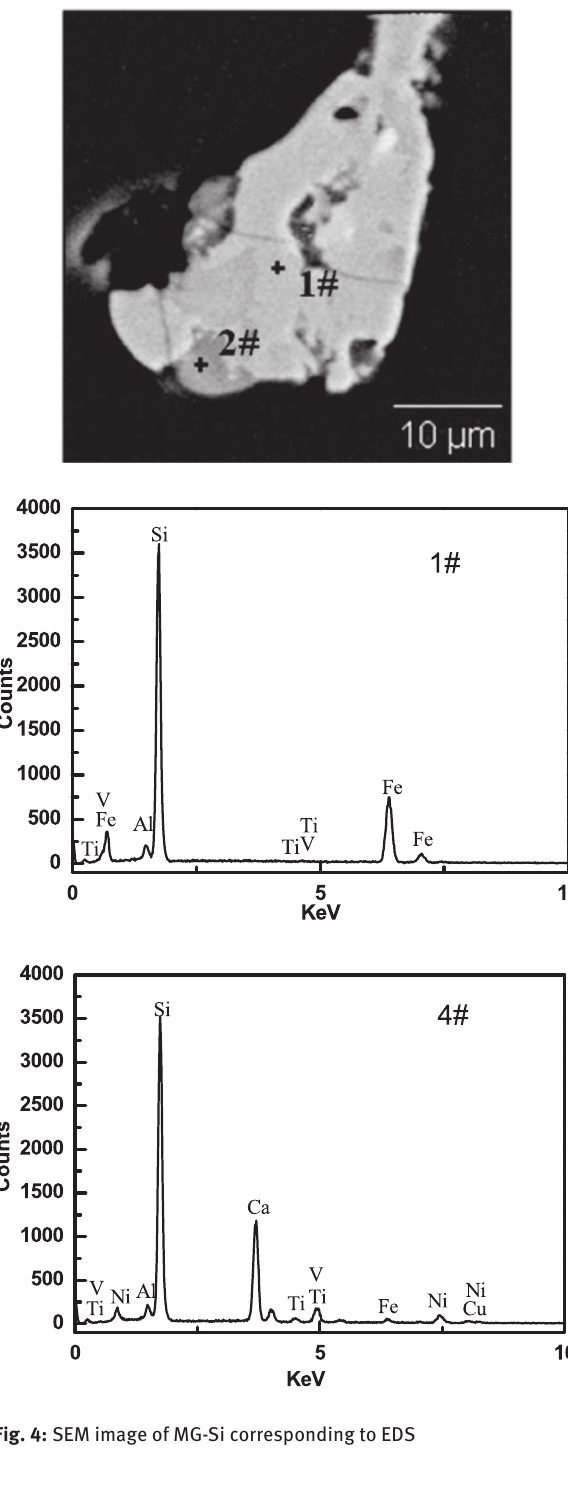
Fig. 4: SEM image of MG-Si corresponding to